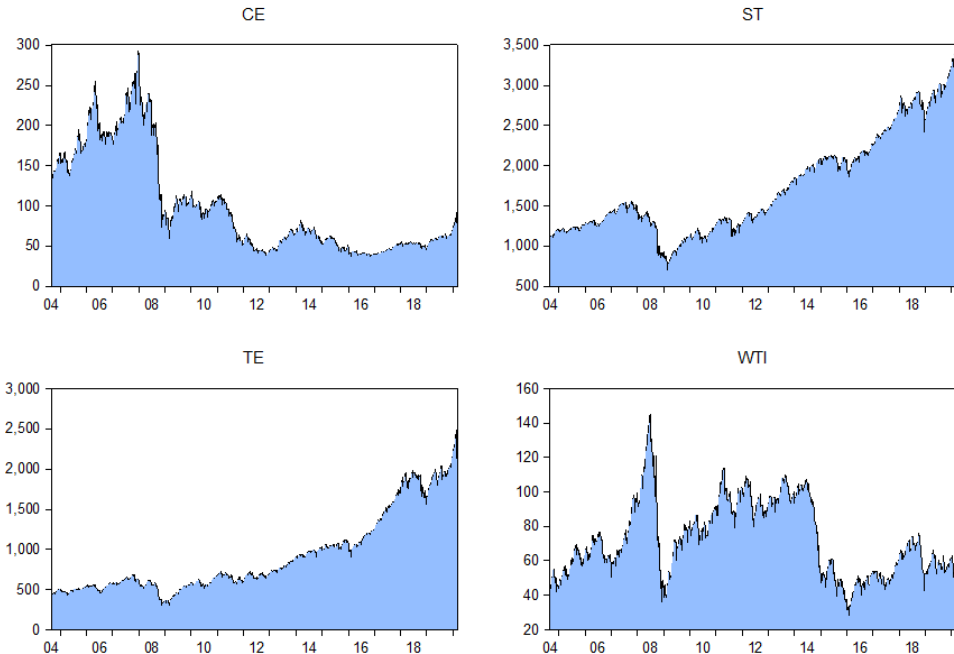
Figure 1. Time series plot of the clean energy (CE), S&P 500 (ST), technology (TE), and crude oil (WTI) series. The y -axis for WTI represents the price per barrel in dollars, and the x -axis shows the sample period. All of the other three assets are indexes, with the y -axis denoting the index value and the x -axis denoting the time.